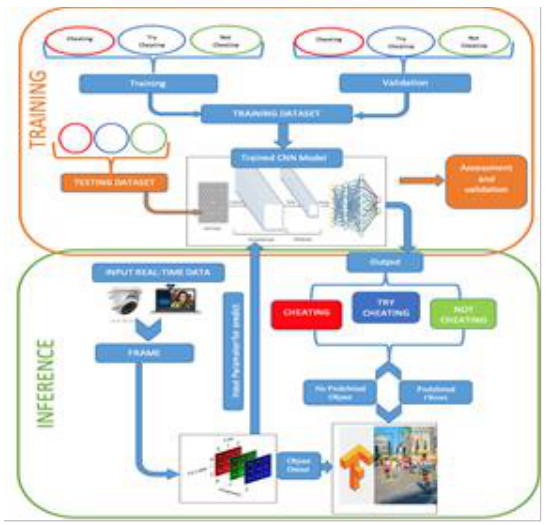
Figure 1. Methodology